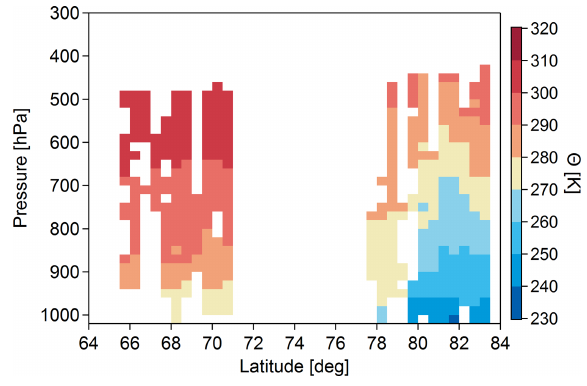
Figure 2. The potential temperature ( (cid:50) ) distribution binned in steps of 1 ◦ latitude and 20hPa pressure. (cid:50) was calculated from the tem- perature and pressure measurements on board the Polar 6 aircraft during the NETCARE 2015 springtime campaign. Minimum po- tential temperatures of less than 270K were only observed in the high Arctic lower troposphere, representing very cold air masses that isolate this area from mid-latitudinal influence. The polar dome is formed by the sloping isentropes which can be identified from the NETCARE measurements. Figure from Bozem et al.